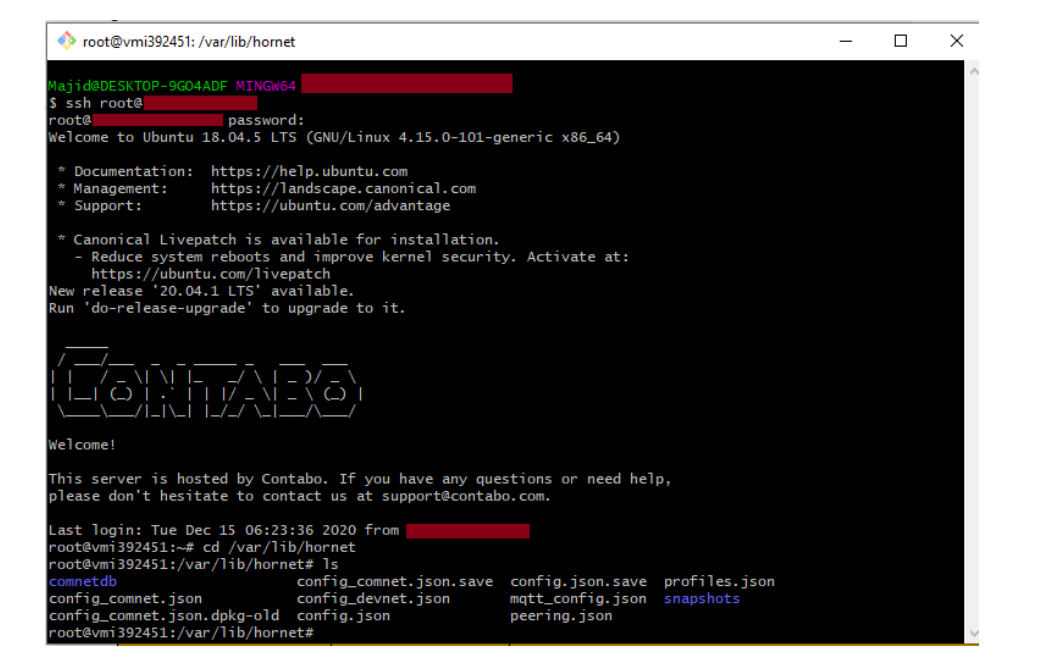
Figure 4. Accessing the Hornet node using SSH via Terminal.